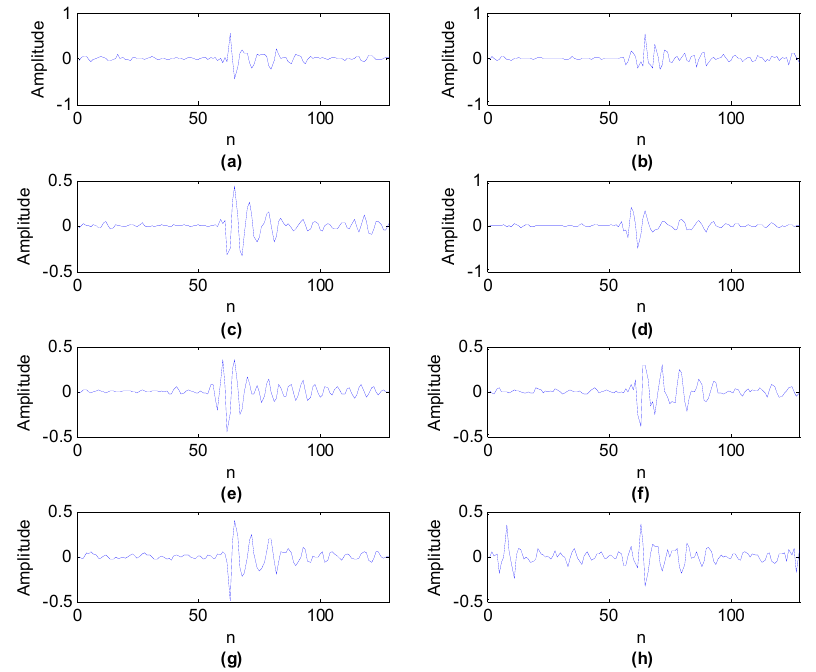
Figure 11. Rolling bearing signal with outer race, inner race and rolling element compound fault: ( a ) time waveform; ( b ) envelope spectrum.